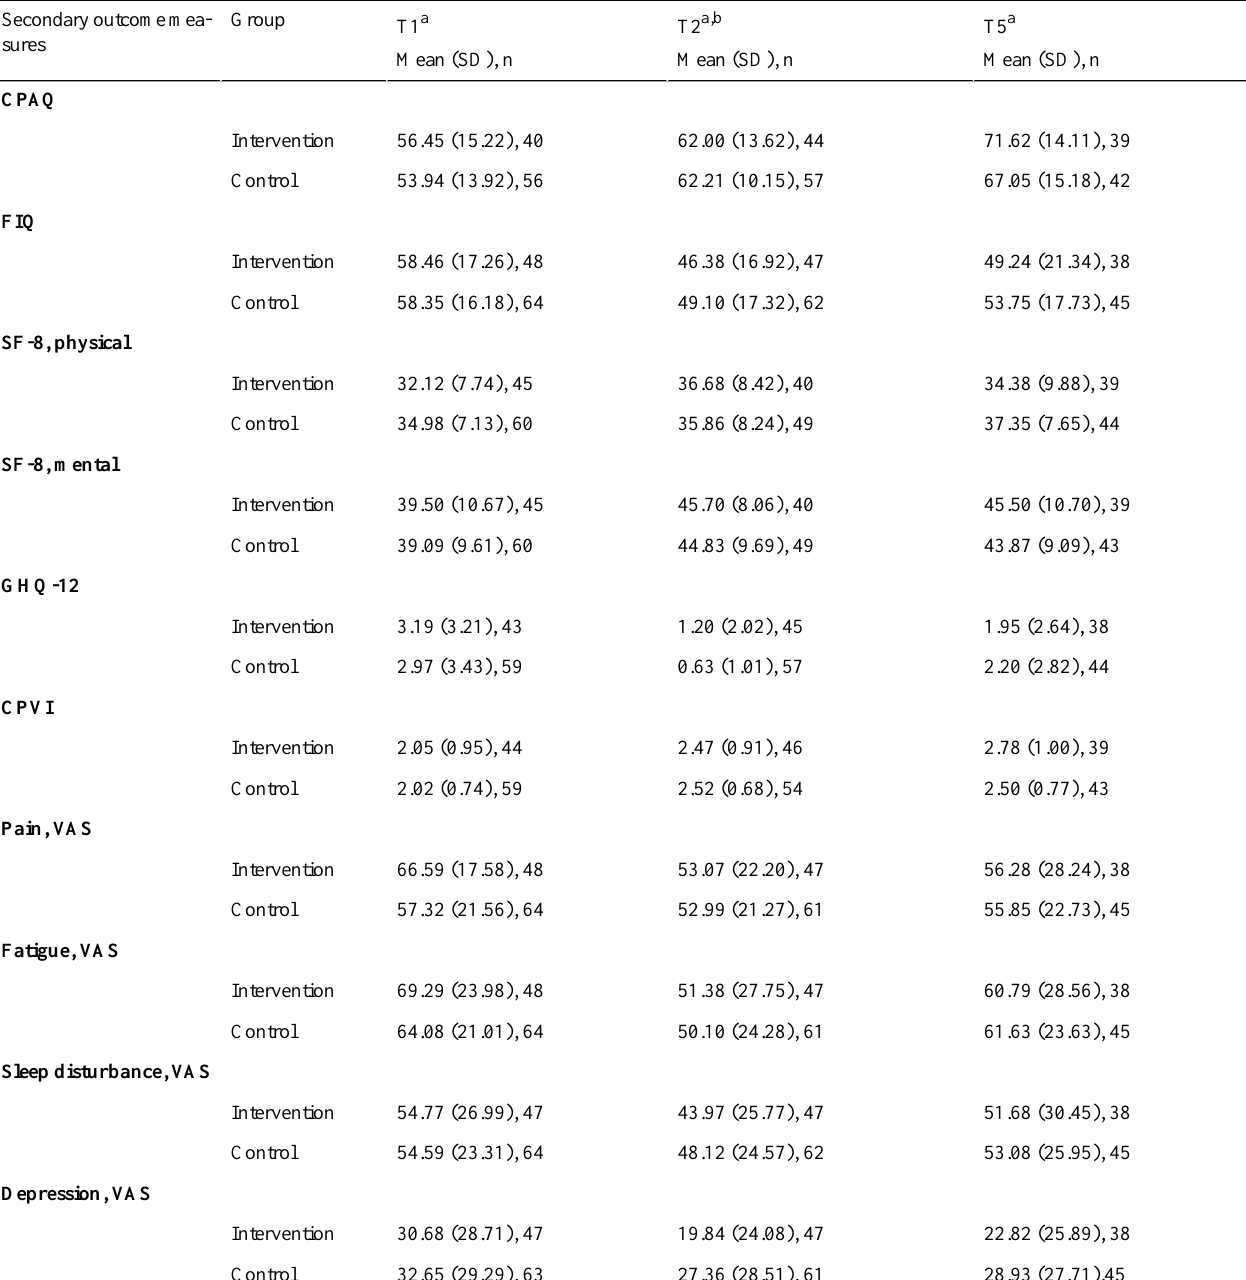
Table 4. Means and standard deviations for the secondary outcomes at admission to the inpatient rehabilitation (T1), at discharge (T2), and 11 months (T5) after the intervention period, for the